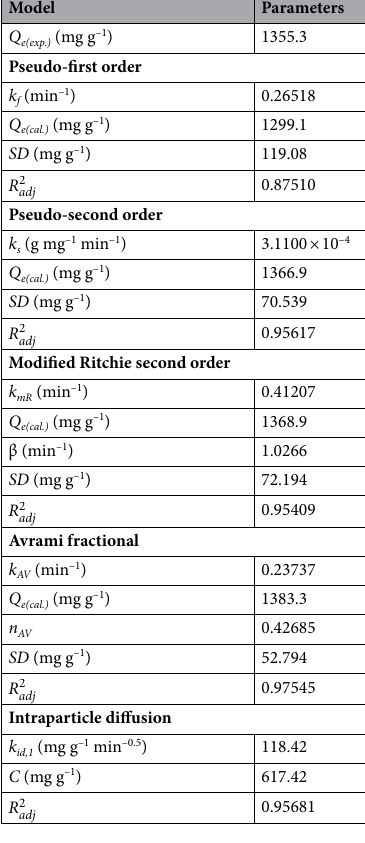
Table 1. Kinetic parameters of adsorption of Congo red by CHCFe. Conditions: initial pH of the solution = 2; mass of adsorbent = 0.05 mg; temperature = 25 °C; agitation time = 0–480 min; initial concentration of Congo red = 2 g L –1 ; volume of Congo red = 20 mL; and agitation speed = 160